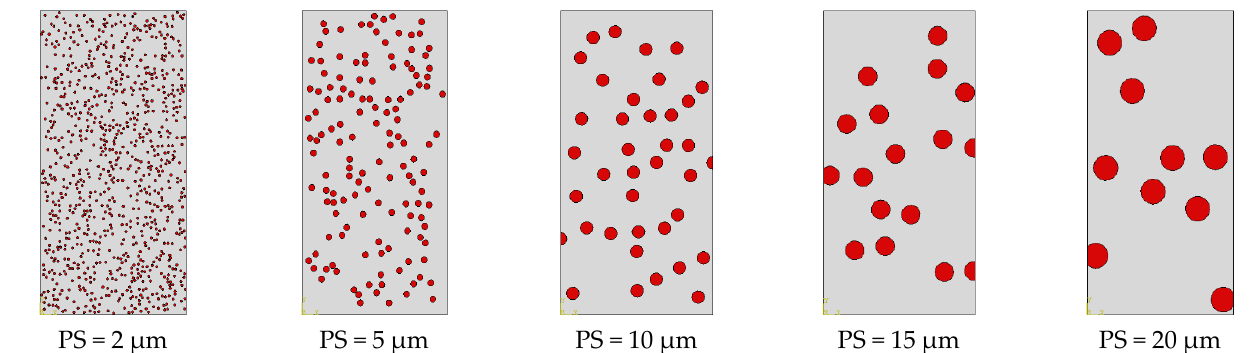
(b) Figure 11. Effective plastic strain in the matrix of A359/SiC composite (PS = 10 µm): ( a ) 5% VF; ( b ) 20% VF. 4.2. Effect of SiC Particles Size ( PS )